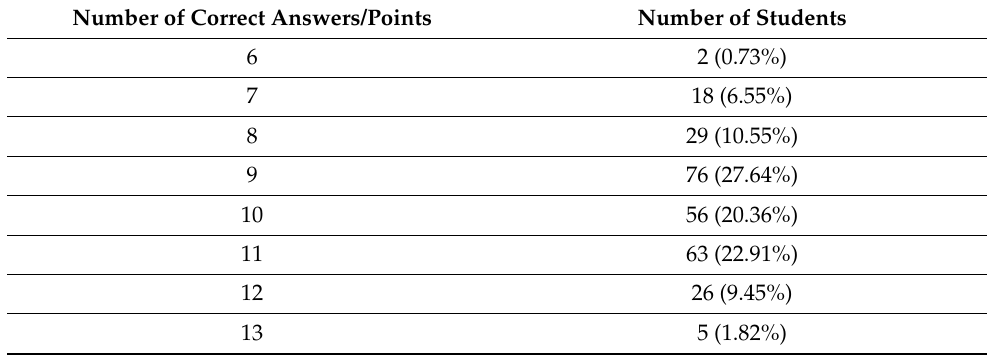
Table 1. Knowledge test results for students of nursing, midwifery and emergency medical services.